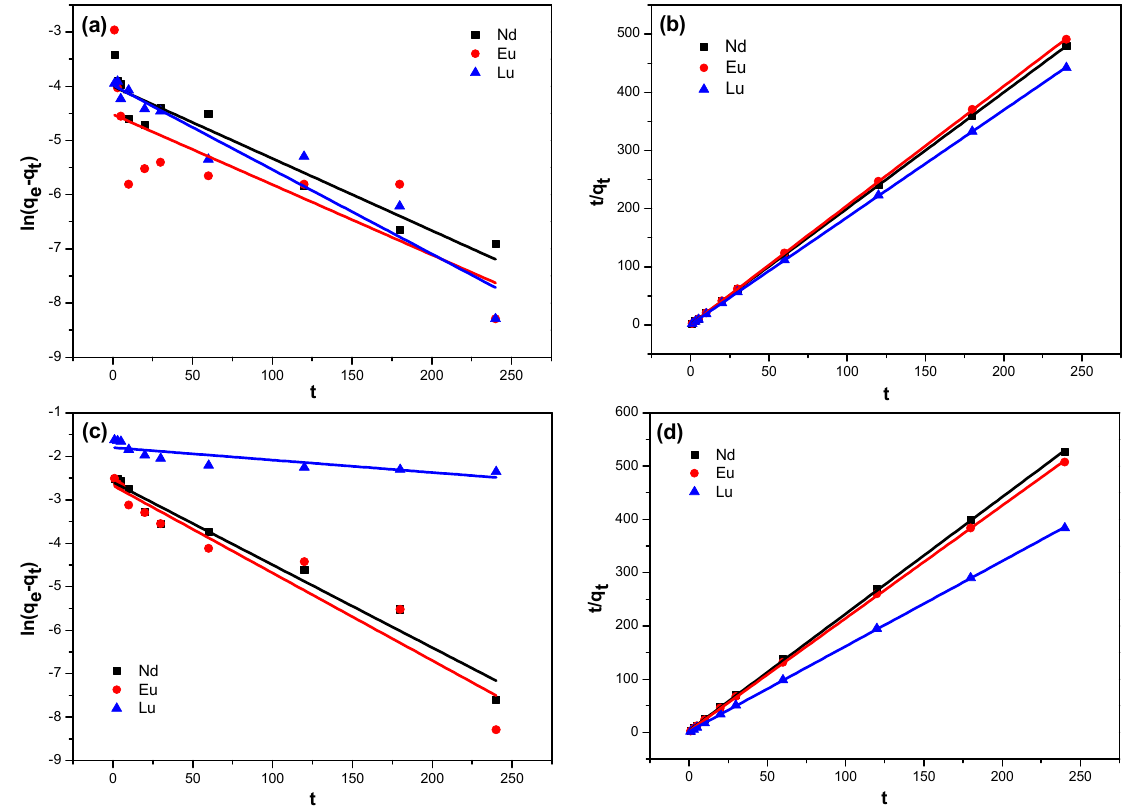
Figure 7. Pseudo-first order, pseudo-second order for Nd 3+ , Eu 3+ and Lu 3+ on halloysite ( a , b ) and illite ( c , d ). Table 2. Kinetics parameters for the adsorption of Nd 3+ , Eu 3+ and Lu 3+ on halloysite and illite. Species